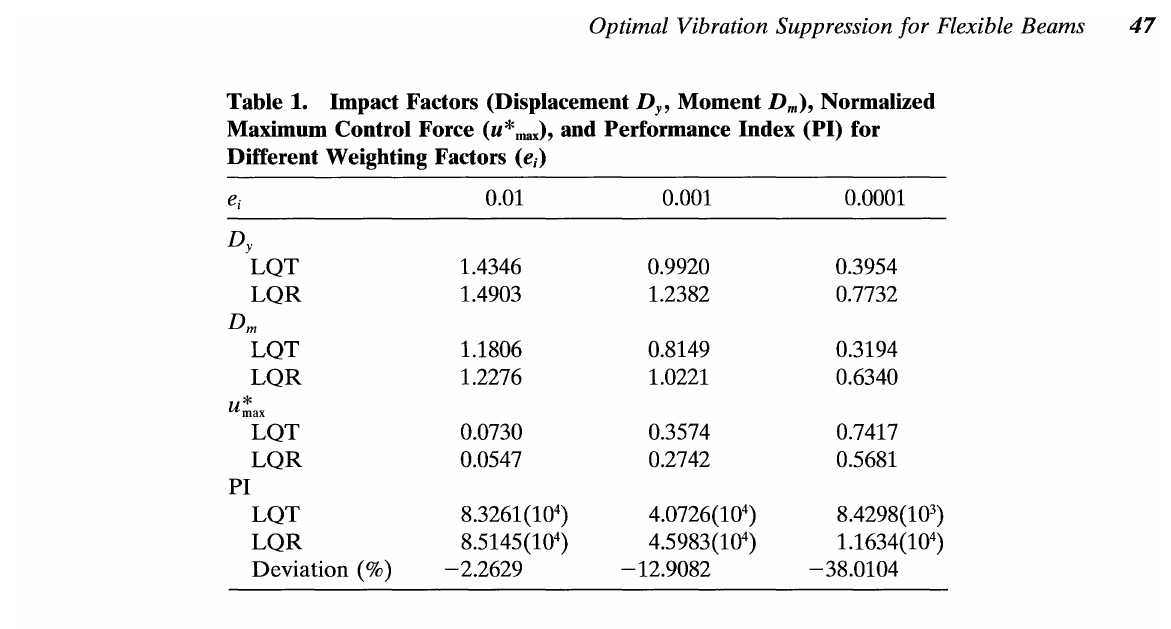
Table 1. Impact Factors (Displacement D y, Moment D m), Normalized Maximnm Control Force (u* max), and Performance Index (PI) for